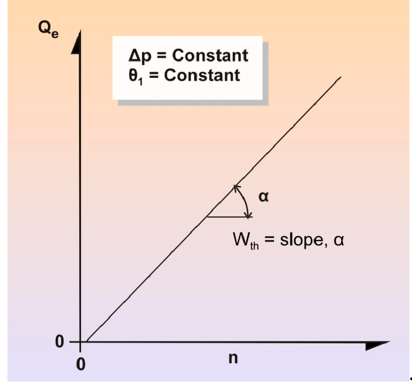
Figure 4. The linear interrelationship between the effective flow Q e of a positive displacement machine and the shaft speed n .